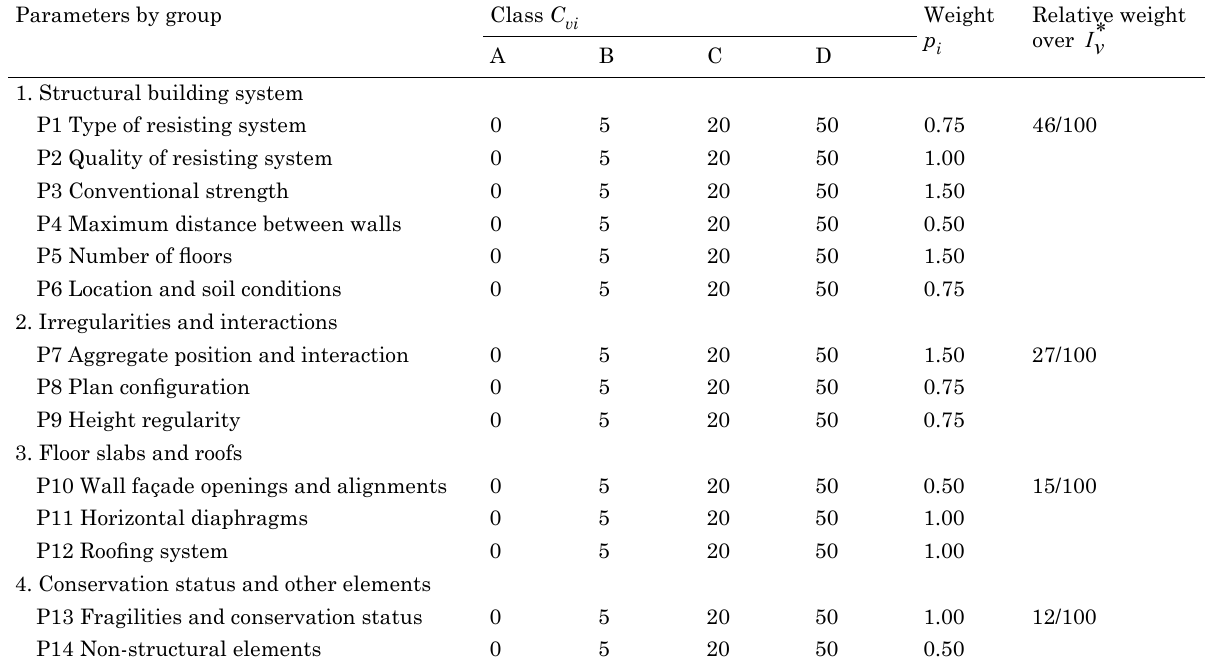
Table 1. Vulnerability index methodology (Vicente 2008) Parameters by